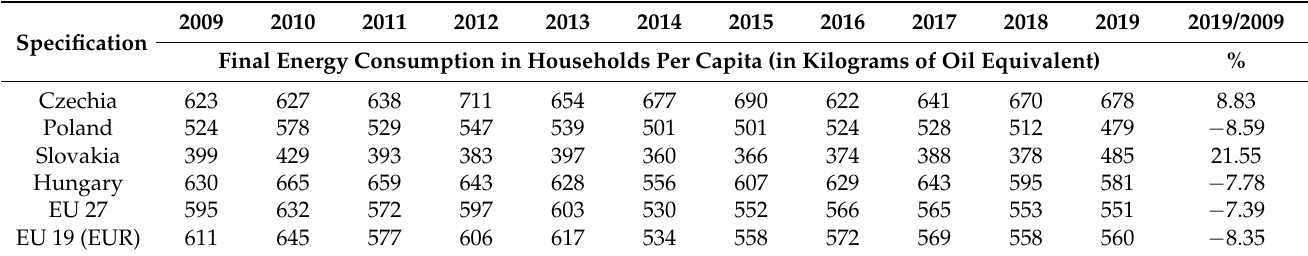
Table 4. Final energy consumption in households per capita and greenhouse gas emissions per capita in the Visegrad Group countries